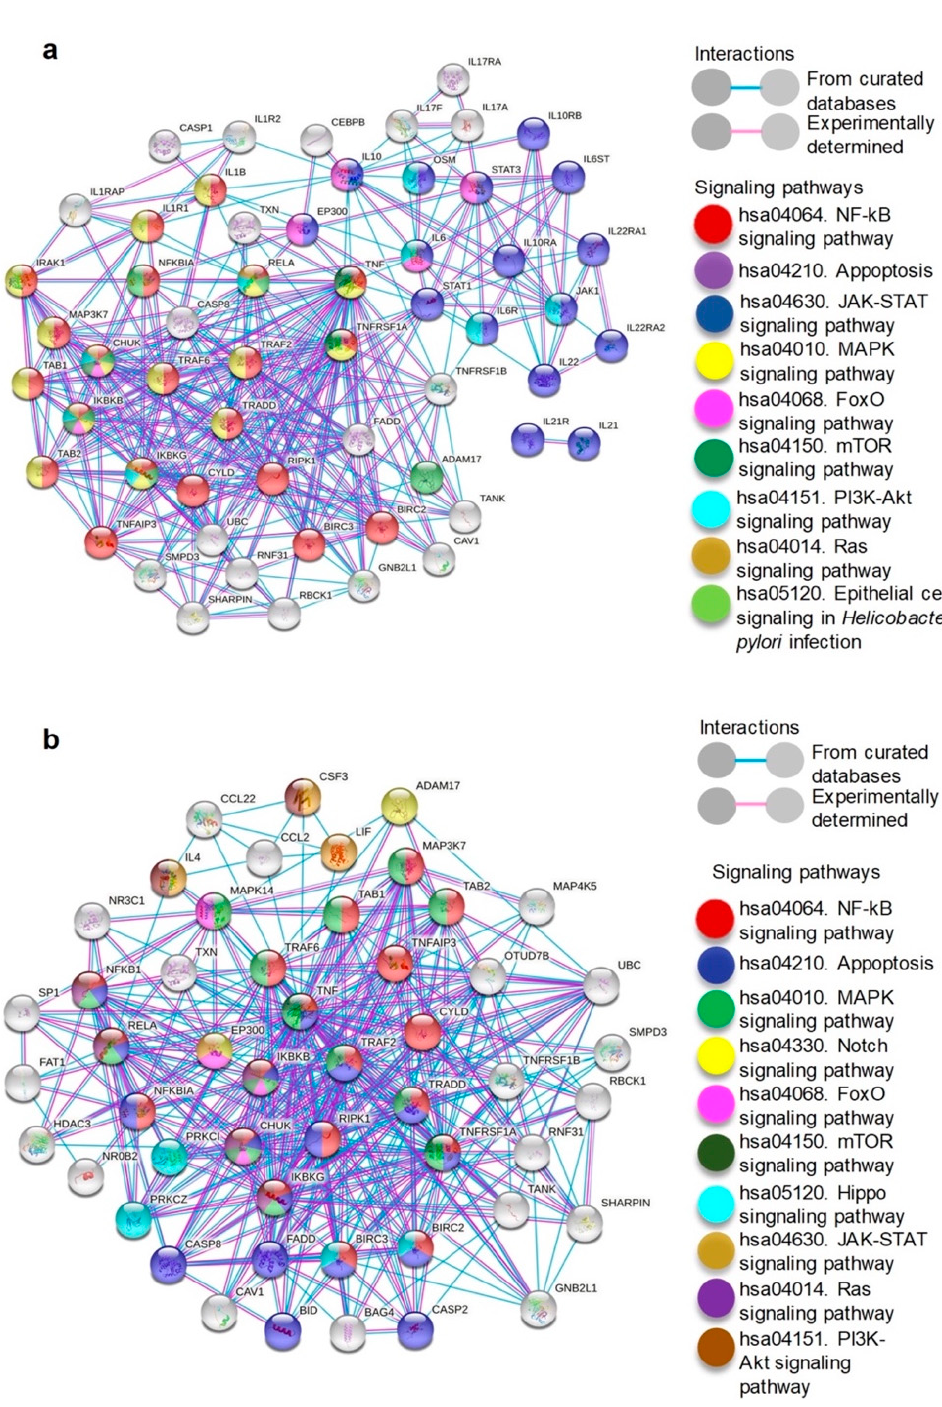
Figure 4. Cytokines increased in the supernatant and exosomes that were secreted by H. pylori - PBMCs participate in the regulation of signaling pathways that are involved in carcinogenesis. ( a ) The PPI network represents physical and functional interactions of IL-1 β , IL-6, TNF- α , IL-10, IL-17A, IL-21, and IL-22 with cellular proteins that participate in signaling pathways that are related to carcinogenesis. ( b ) The PPI network constructed with TNF- α and cellular proteins. Each node represents a protein and the lines represent the interactions between the proteins (edges); pink lines denote experimentally tested interactions, and the blue lines denote the interactions with proteins from curated databases. Colored nodes represent KEGG pathways that are involved in carcinogenesis and white nodes symbolize proteins that are not involved in KEGG pathways. All interactions were statistically significant ( p = 1.0 × 10 − 16 ).